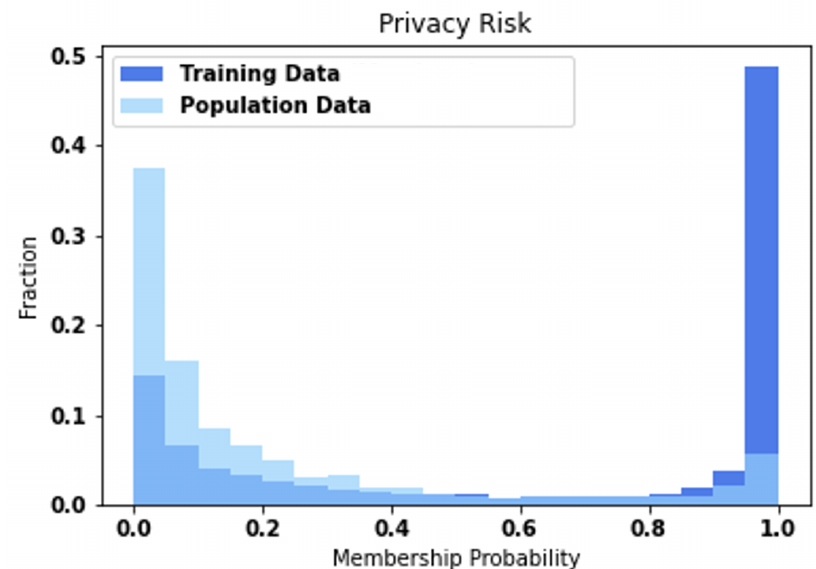
Figure 22. Privacy risk of the baseline model.